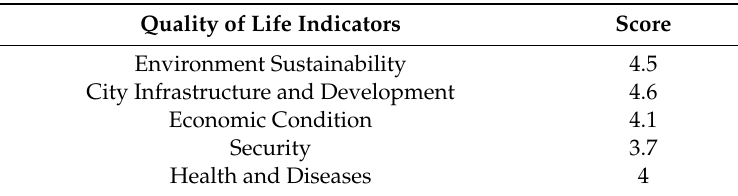
Table 1. Questionnaire